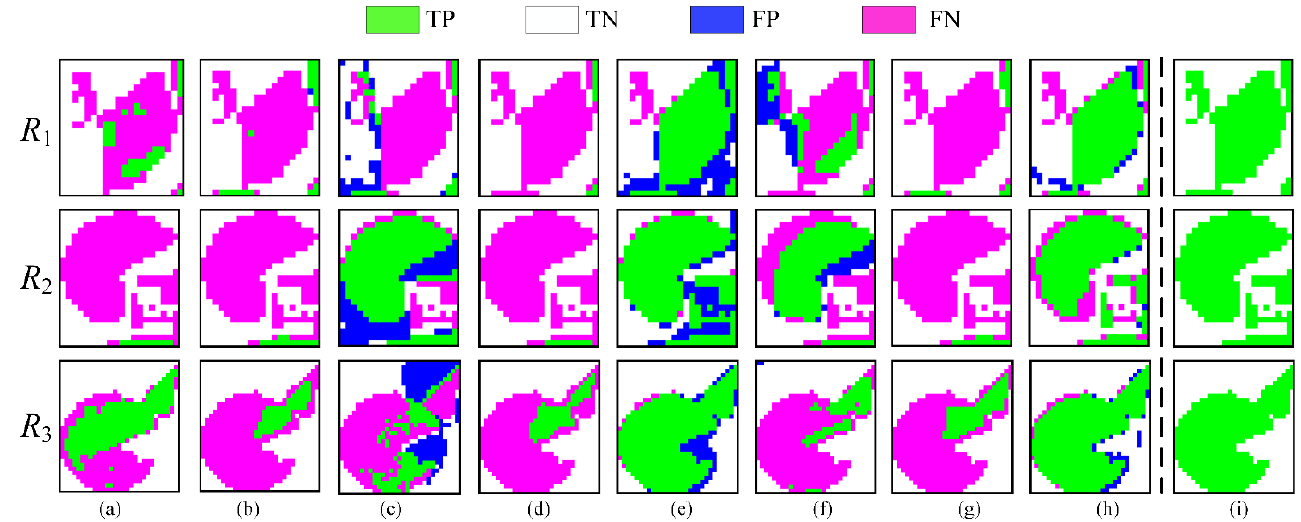
Figure 12. Detection details of the selected regions R 1 , R 2 , and R 3 on the USA dataset using different methods: ( a ) CVA, ( b ) SSIM, ( c ) ISFA, ( d ) IRMAD, ( e ) MaxtreeCD, ( f ) Unet, ( g ) SGCL, ( h ) SSCF, ( i ) Ground-truth.